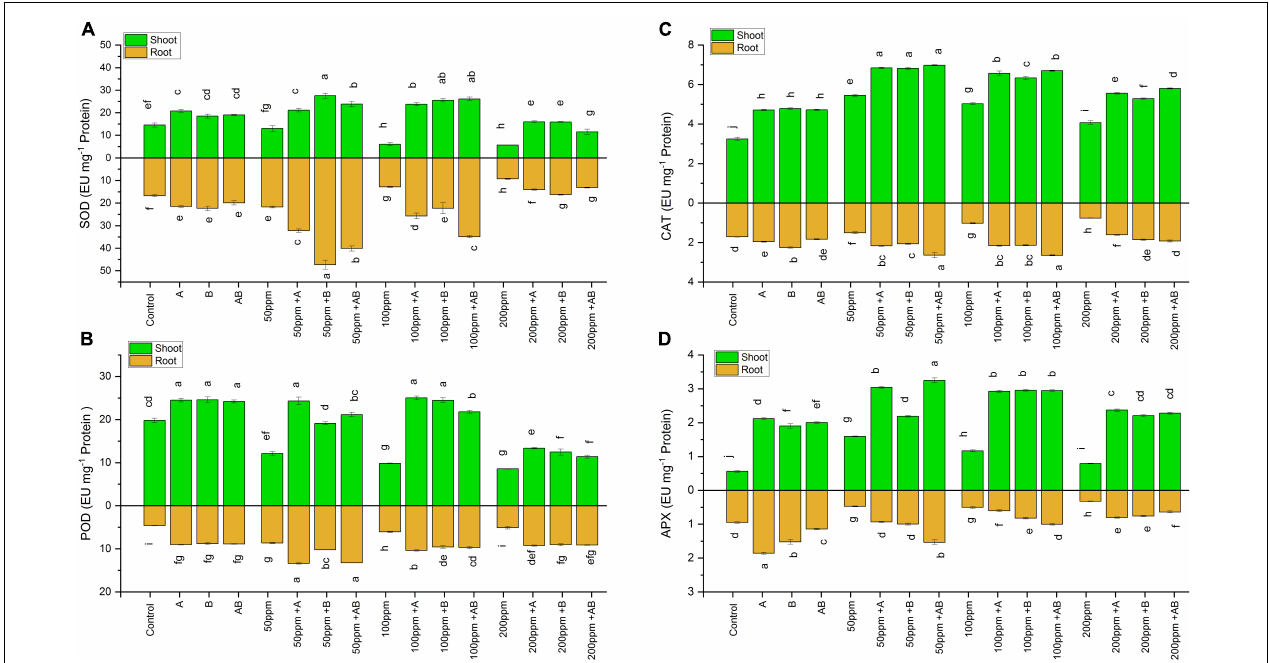
FIGURE 6 | Effect of heavy metal–resistant plant growth–promoting bacteria on (A) SOD, (B) POD, (C) CAT, and (D) APX activity of wheat ( Triticum aestivum L.) in plants under control and heavy metal (Cd, Ni, Pb) stress conditions. Values are the mean of three replicates. Bars represent the standard error of means. Different letters above bars the indicate statistically significant difference between treatments at P ≤ 0.05. Details of treatments are the same as those in Figure 1 .